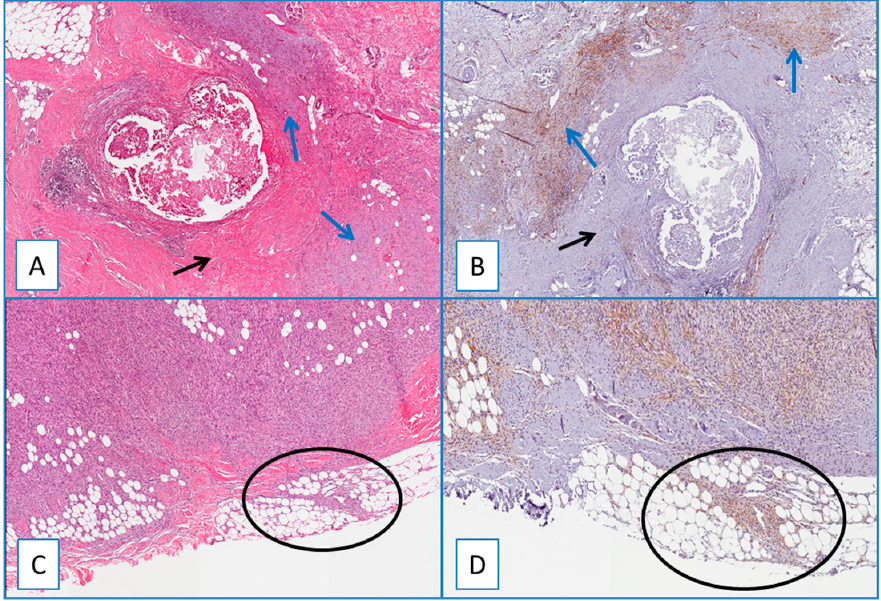
Figure 3. ( A ) Residual/recurrent DFSP: low magnification showing a residual neoplastic component (blue arrows) and fibroblasts/myofibroblasts of the surgically related scar tissue (black arrow) (H&E; original magnification 50 × ); ( B ) serial section showing a diffuse and strong cytoplasmic immunore- activity of WT1 restricted to neoplastic cells (blue arrows), while the fibroblasts/myofibroblasts of the surgically related scar tissue are unstained (black arrow) (immunoperoxidase; original magnifi- cation 50 × ); ( C ) residual/recurrent DFSP: bland-looking neoplastic spindle cells infiltrating at the surgical margins (circle) (H&E; original magnification 50 × ); ( D ) serial section showing that these cells are stained with WT1, further supporting their neoplastic nature (circle) (immunoperoxidase; original magnification 50 ×